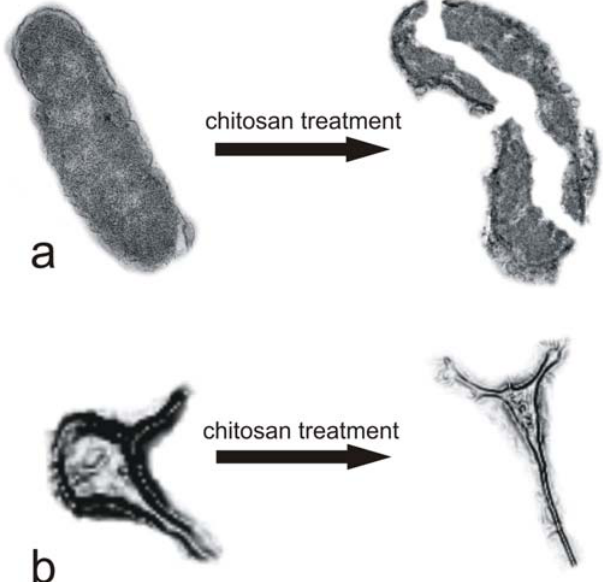
Figure 8. Schematic representation of chitosan´s impact on the Gram-negative bacterium E. coli (a) and on brain cells (b) . Bacteria show lysis accompanied by death in the presence of chitosan, whereas brain cells show a change in their overall shape; their functionality and vitality are, however, not affected by the chitosan